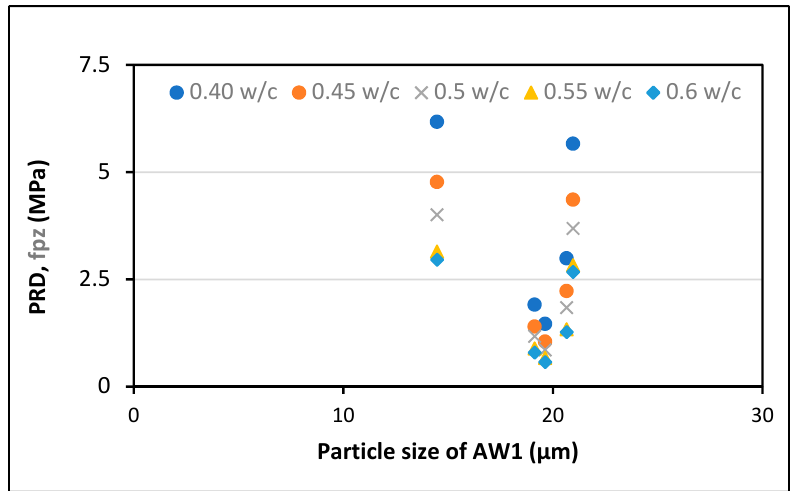
Figure 4. Discrepancy trends of the pozzolanic impact with the particle diameter and w/c ratio.